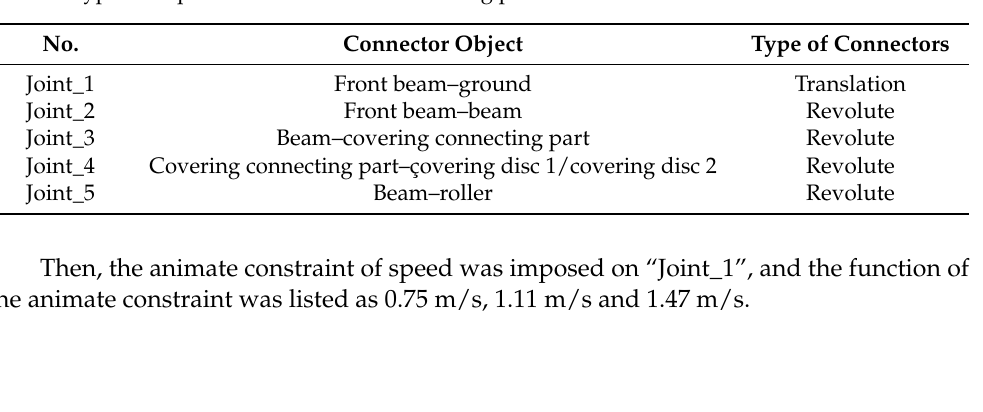
Figure 9. A 3D model of the precision seeding unit with constrains presented.